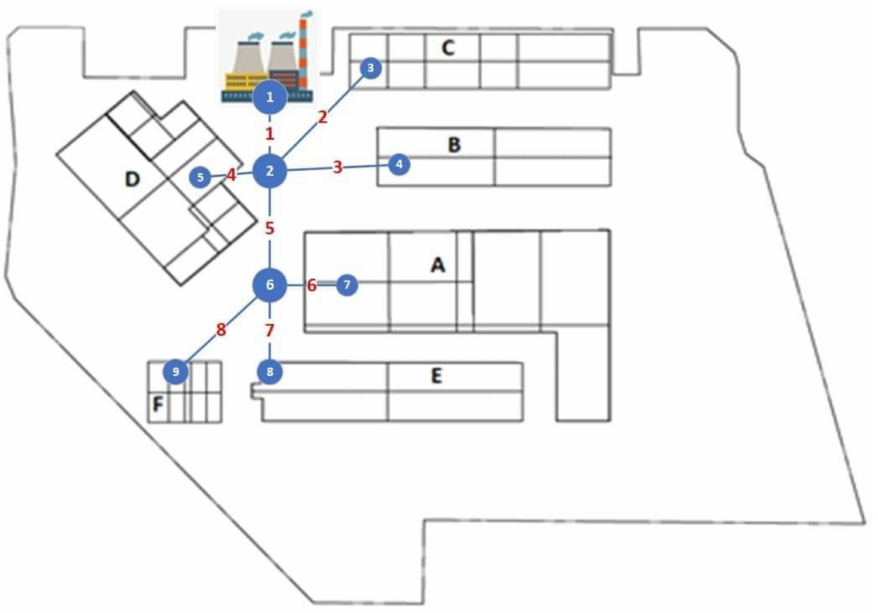
Figure 5. Configuration of the buildings in the newly designed geometry and designed supply and return network for heating and